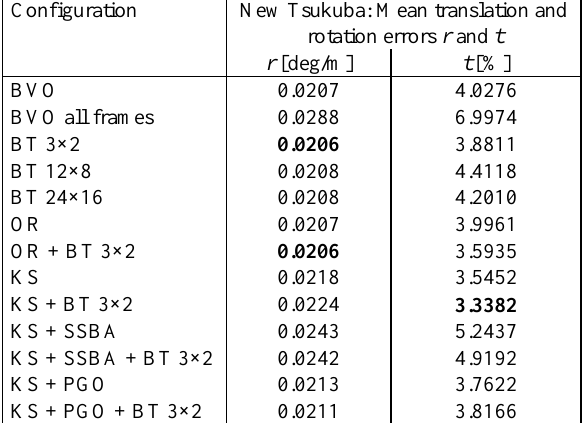
Table 1. Mean translation and rotation error rates for Tsukuba: